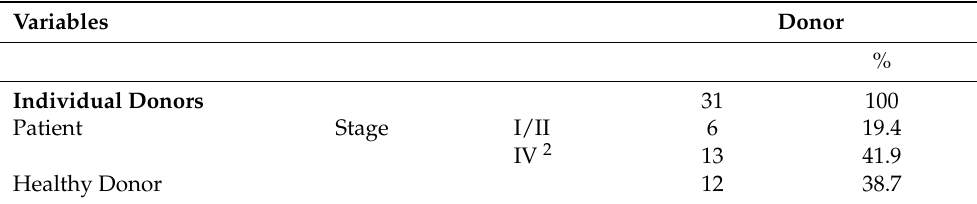
Table 2. Patients and healthy donors included in phenotyping eosinophils and for cytotoxicity evaluation 1 .